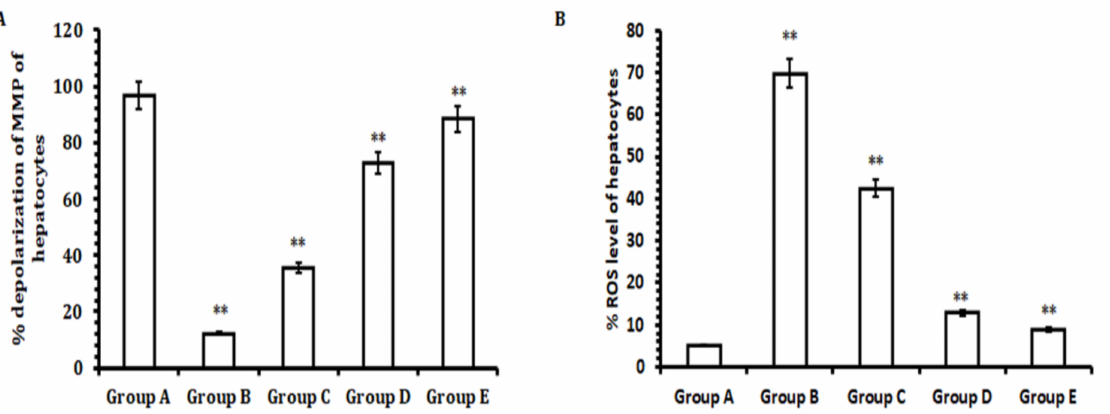
Figure 5. Measurement of MMP and ROS production of liver hepatocytes extracted from the livers of rats initially treated with CCl 4 and the effect of TA extract on MMP and ROS production. ( A ) Measurement of the MMP of hepatocytes extracted from different animal groups initially dosed with CCl 4 , ( B ) ROS production of hepatocytes extracted from different animal groups initially dosed with CCl 4 . The experi- ments were performed three or more than three times and the data are represented as the mean ± SEM. A p -value less than or equal to 0.05 was considered statistically significant, i.e., ** p ≤